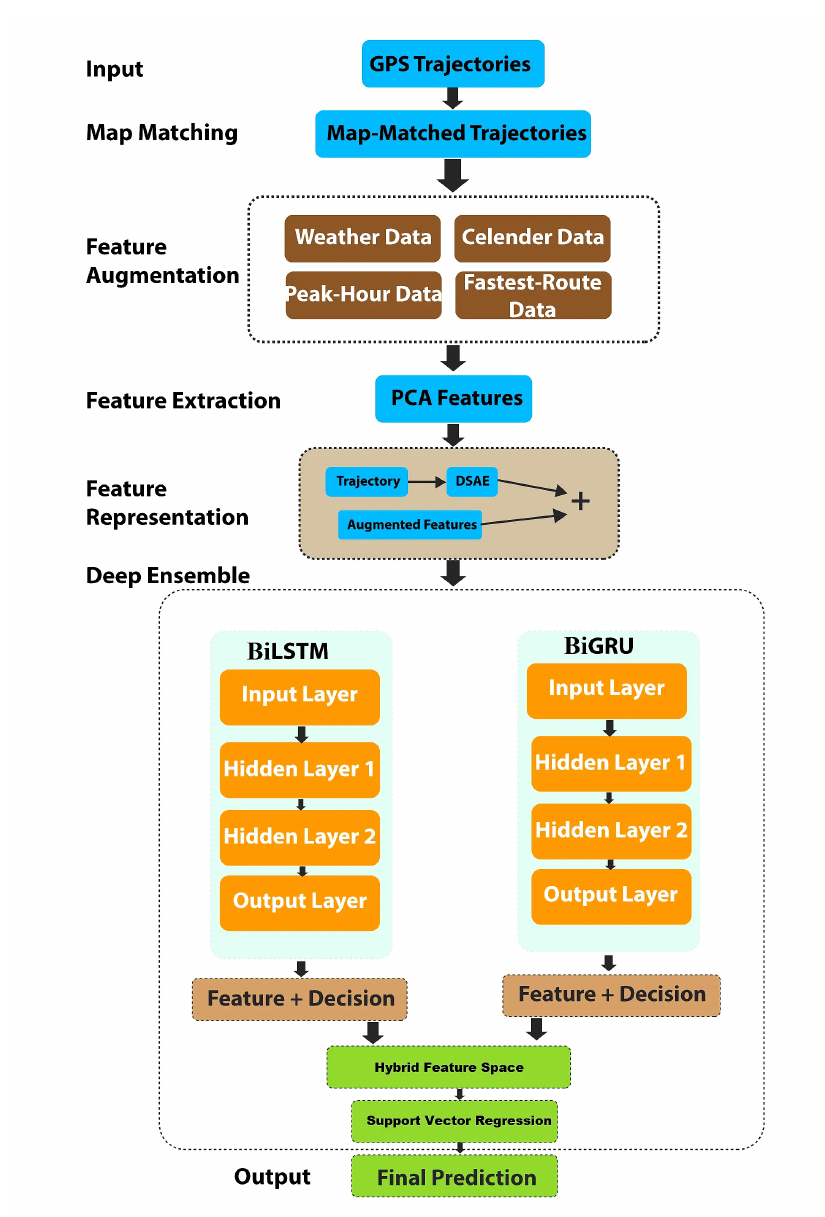
Figure 2. An overview of the proposed